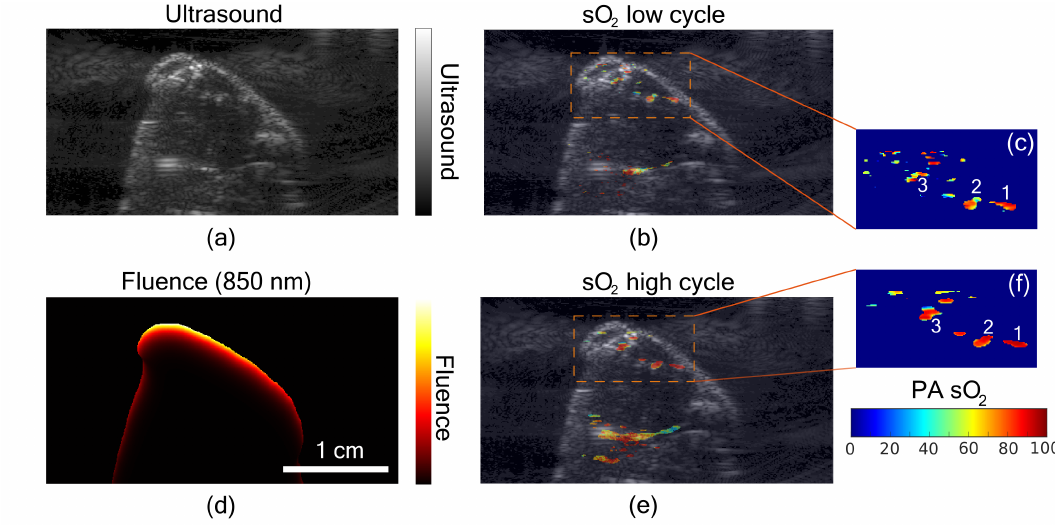
Figure 5. In vivo small animal imaging. ( a ) Ultrasound image of the thigh muscle of a mouse. ( b ) Fluence compensated photoacoustic oxygen saturation (PA sO 2 ) during the low sO 2 cycle overlaid on the ultrasound image. ( c ) Zoomed-in region of the PA sO 2 image from the low sO 2 cycle. ( d ) Fluence map at 850 nm obtained using segmented ultrasound image. ( e ) Fluence compensated PA sO 2 during the high sO 2 cycle, overlaid on the ultrasound image. ( f ) Zoomed-in region of the PA sO 2 image from the high sO 2